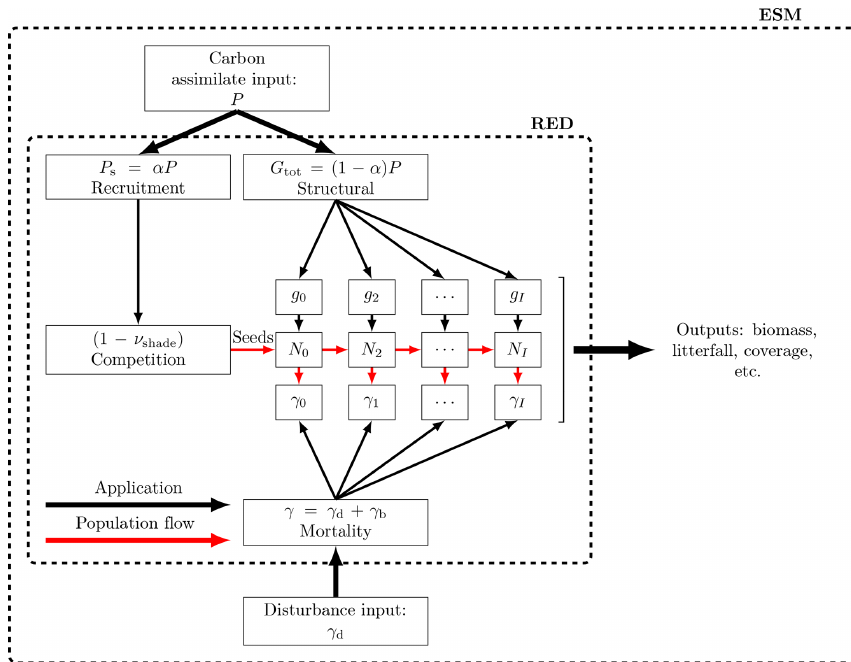
Figure 2. Schematic of RED coupled to an ESM or land carbon cycle model. RED is driven by a time series of net carbon assimilate, P , which is then split between seedling production, αP , and the growth of existing plants, G = ( 1 − α)P . The seedling flux is limited by the available free space, s . Additional mortality rates diagnosed from disturbance models, γ d , can be added onto an assumed baseline mortality, γ b , as a function of both PFT and mass class. Table 3. List of PFT names and assumed allometric scaling parameters ( m 0 ,a 0 ,h 0 ), seedling fraction ( α ), and competition coefficient ( c pft ,j ). The growth allometry of trees and shrubs across size is assumed to follow Niklas and Spatz (2004) ( φ g = 0 . 75, φ a = 0 . 5, φ h = 0 . 25). The competition coefficients given describe which PFT functional group shades the current PFT; if c pft ,j = 1, the PFT is shaded; otherwise it is not (Table 2).